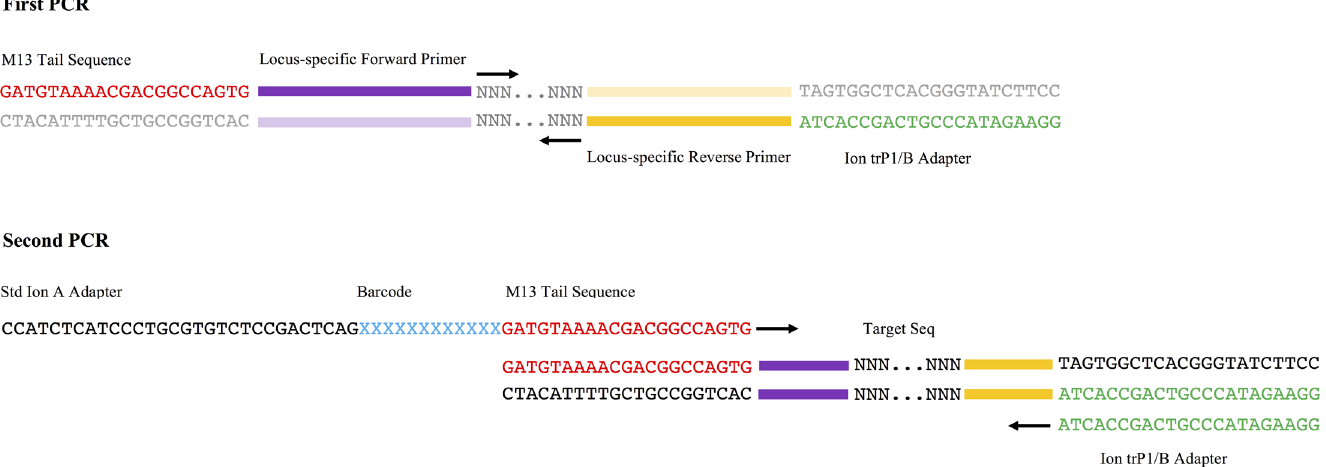
Fig 1. GBMAS two-step PCR. The first PCR is a multiplex and amplifies the different target regions containing SNP(s). The locus-specific forward primers were tailed with an M13 sequence at the 5 ’ -end and the reverse primers were tailed with Ion truncated P1/B sequence. The generated amplicons contains an M13 tail and Ion truncated P1/B sequence. The second PCR involves the addition of barcodes and standard Ion A adapter to the